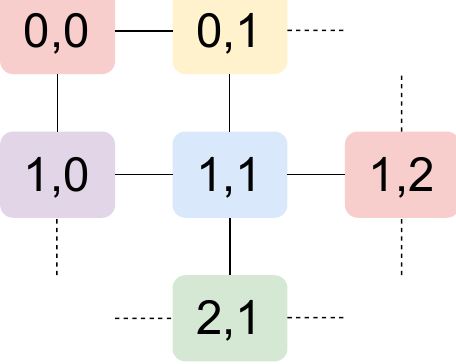
Figure 1. Square grid topology